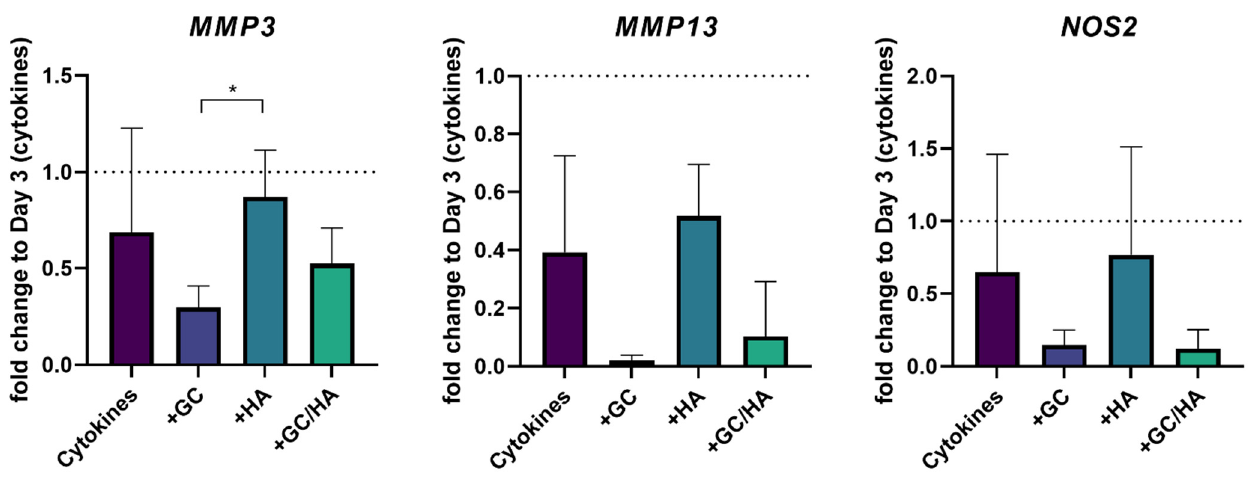
Figure 6. Expression of the catabolic genes MMP3 , MMP13 and NOS2 ; shown as fold change to day 3, when test substances (10%) were added. The single asterisk indicates p < 0.05. The dotted lines represent the gene expression of cytokine-treated chondrocytes after 3 days, before test substances were added.